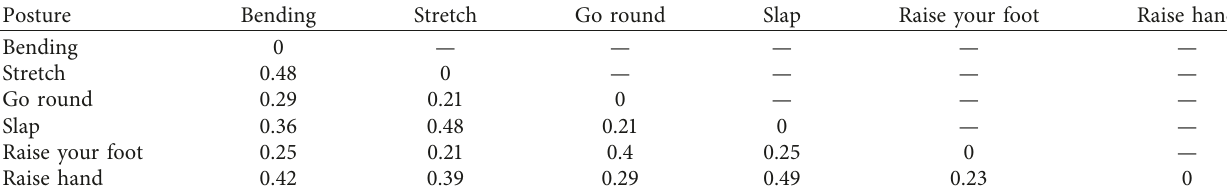
Table 1: Distance matrix of six typical poses.